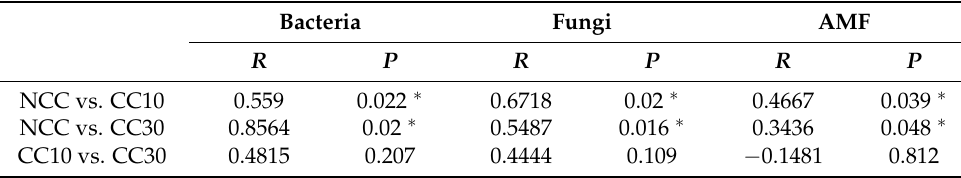
Figure 1. Box plots showing ACE richness and Shannon diversity index of bacteria, fungi and AM fungi ( A1 – C2 ). Unconstrained PCoA (for principal coordinates PC1 and PC2) with Bray-Curtis distance from bacterial ( D ), fungal ( E ) and arbuscular mycorrhizal fungal ( F ). Relative abundances of the top bacterial ( G ), fungal ( H ), and arbuscular mycorrhizal fungal ( I ) phyla or Orders. NCC: first-year monoculture; CC10: ten-year continuous monoculture; CC30: thirty-year continuous monoculture. Table 3. ANOSIM analysis between sugarcane cropping